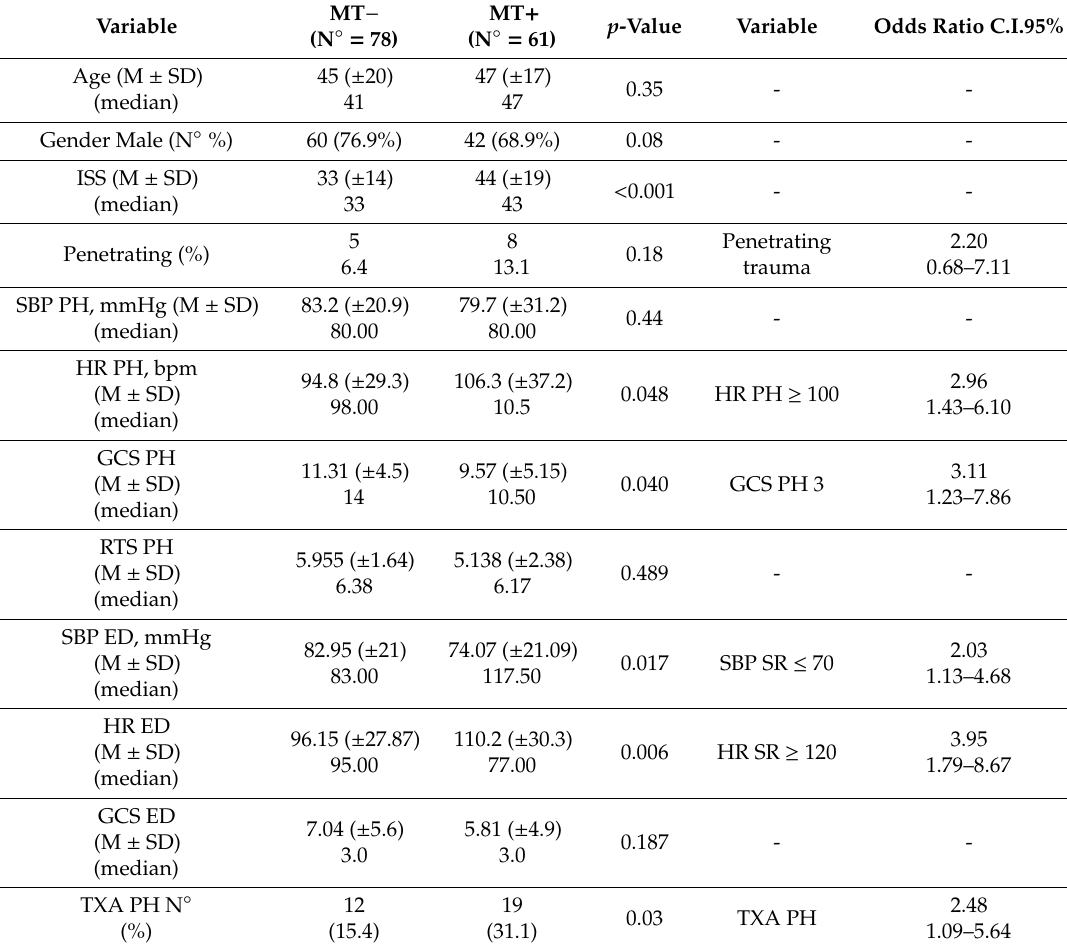
Table 1. Left: Demographic and hemodynamic variables of patients from Milano trauma registry. Right: Variables significantly associated with MT at univariate analysis.